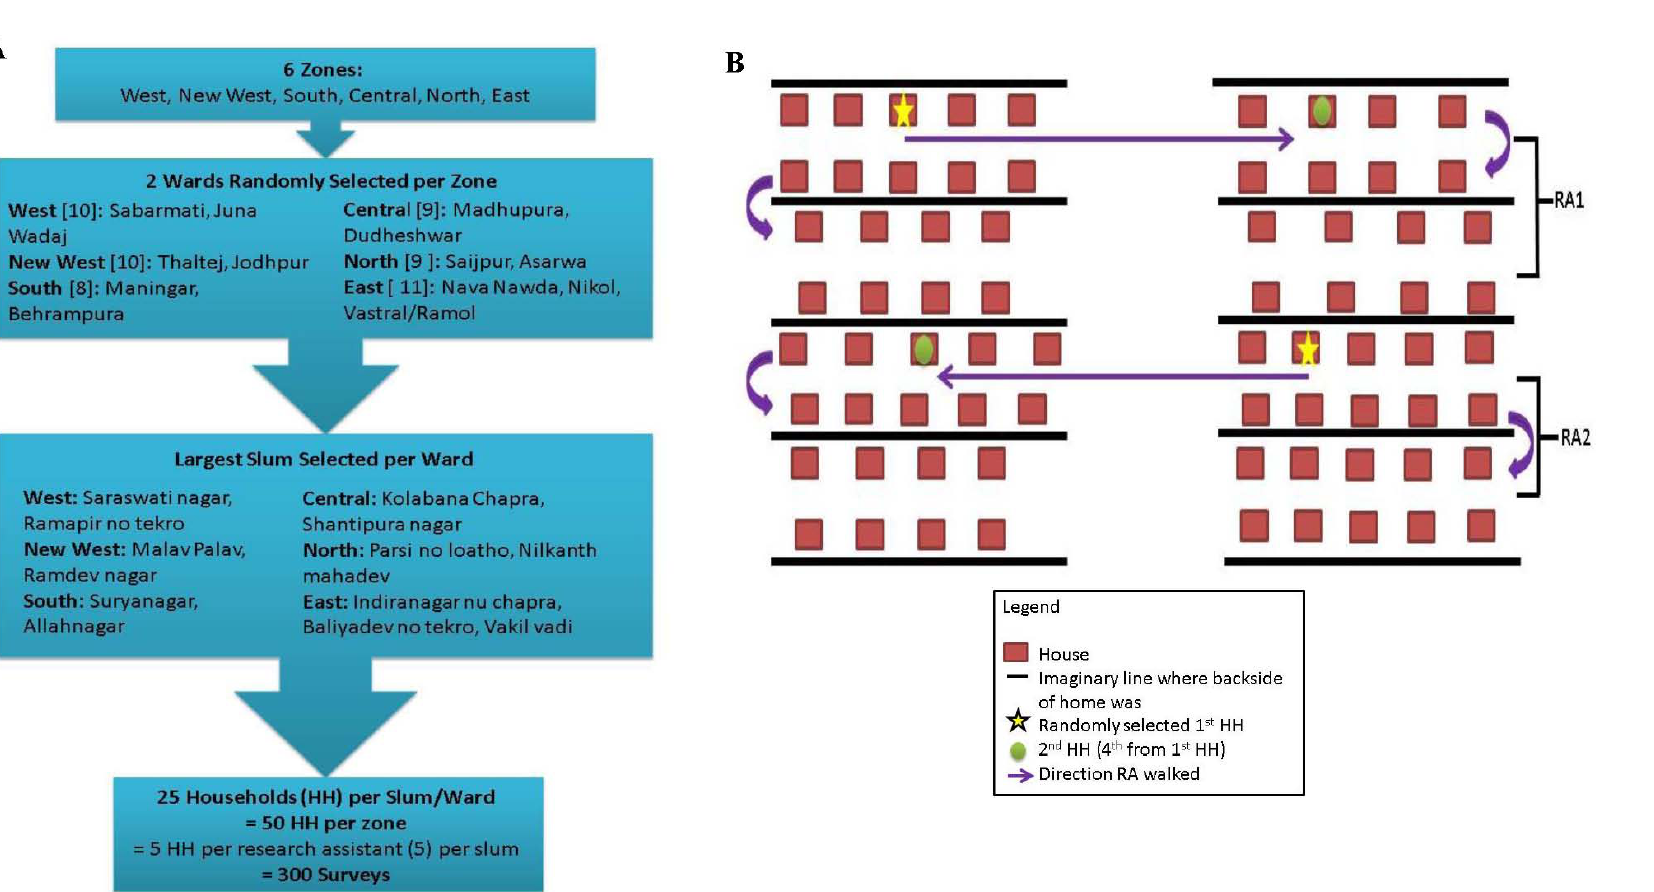
Figure S1. ( A ) Sampling design: Among the 6 city zones, two wards were randomly selected per zone (out of 57). The largest slum was selected (12 and one additional in East zone where boundaries were unclear), where 25 households were surveyed for a total of 25 households per slum and 300 total surveys; ( B ) Household selection method : The neighborhood layout varied among slums. An example of one organized by parallel lanes is shown. Research assistants (5) randomly selected one household to begin at in assigned area. After the initial household, they proceeded to every fourth, right or left of the